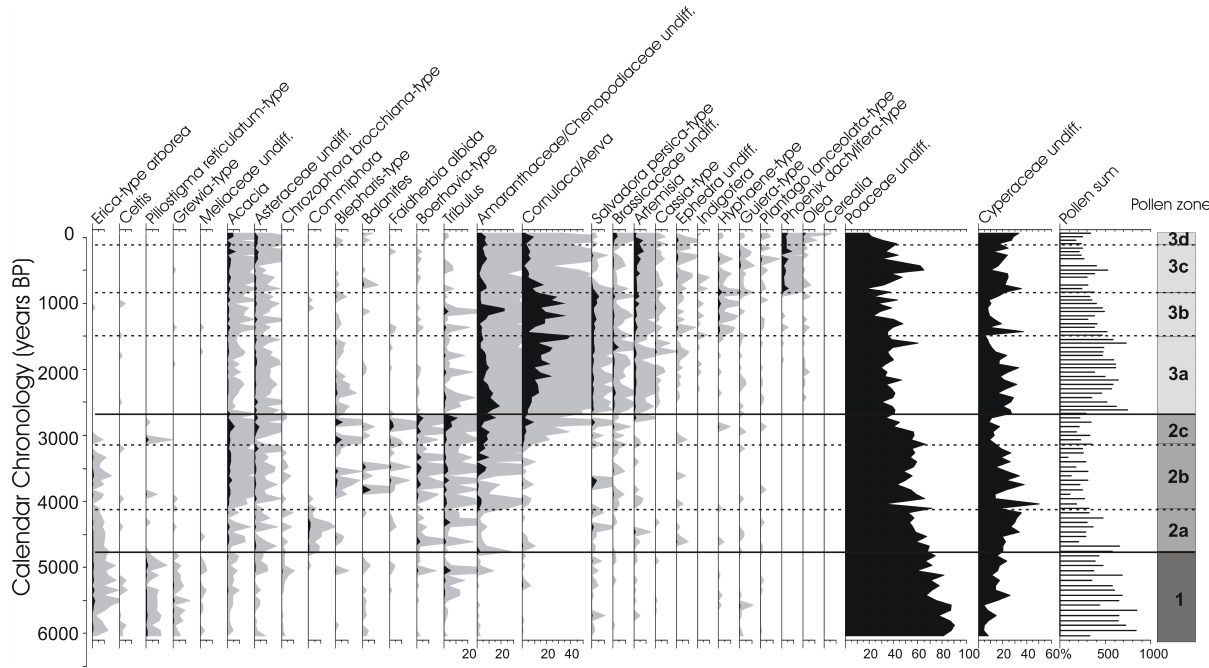
Fig. 3. Lake Yoa synthetic pollen diagram of percentages versus time. Only the major pollen types are